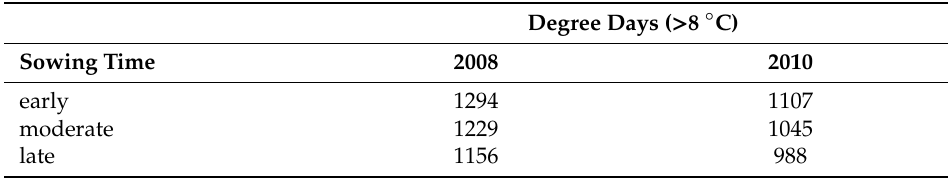
Figure 3. Soil temperatures at 10 cm depth during the cultivation of winter oilseed rape from August to July in Elsdorf (2008) and Titz (2010). Table 3. Final degree days (>8 °C) calculated from average soil temperature in 10 cm soil depth from sowing to harvest under winter oil seed rape at different sowing times.